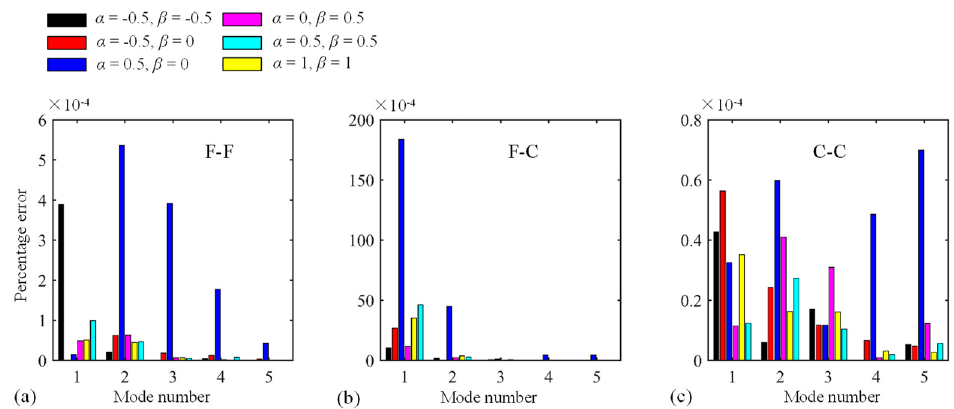
Figure 6. Percentage error of Ω for diverse combinations of α and β . ( a )F-F boundary condition; ( b ) F-C boundary condition; ( c ) C-C boundary condition